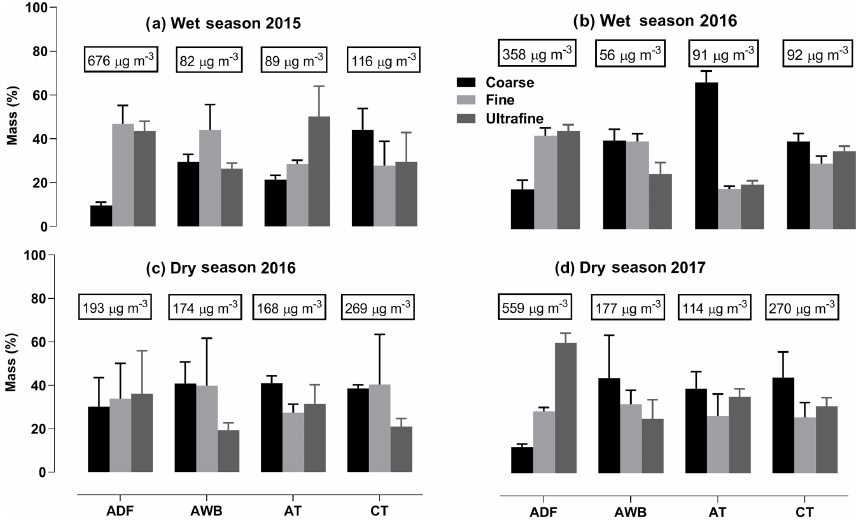
Figure 6. Aerosol mass concentrations at the different study sites for each campaign and for the different sizes (C in black, fine in light grey, ultrafine in grey). Bulk aerosol mass is indicated in boxes.